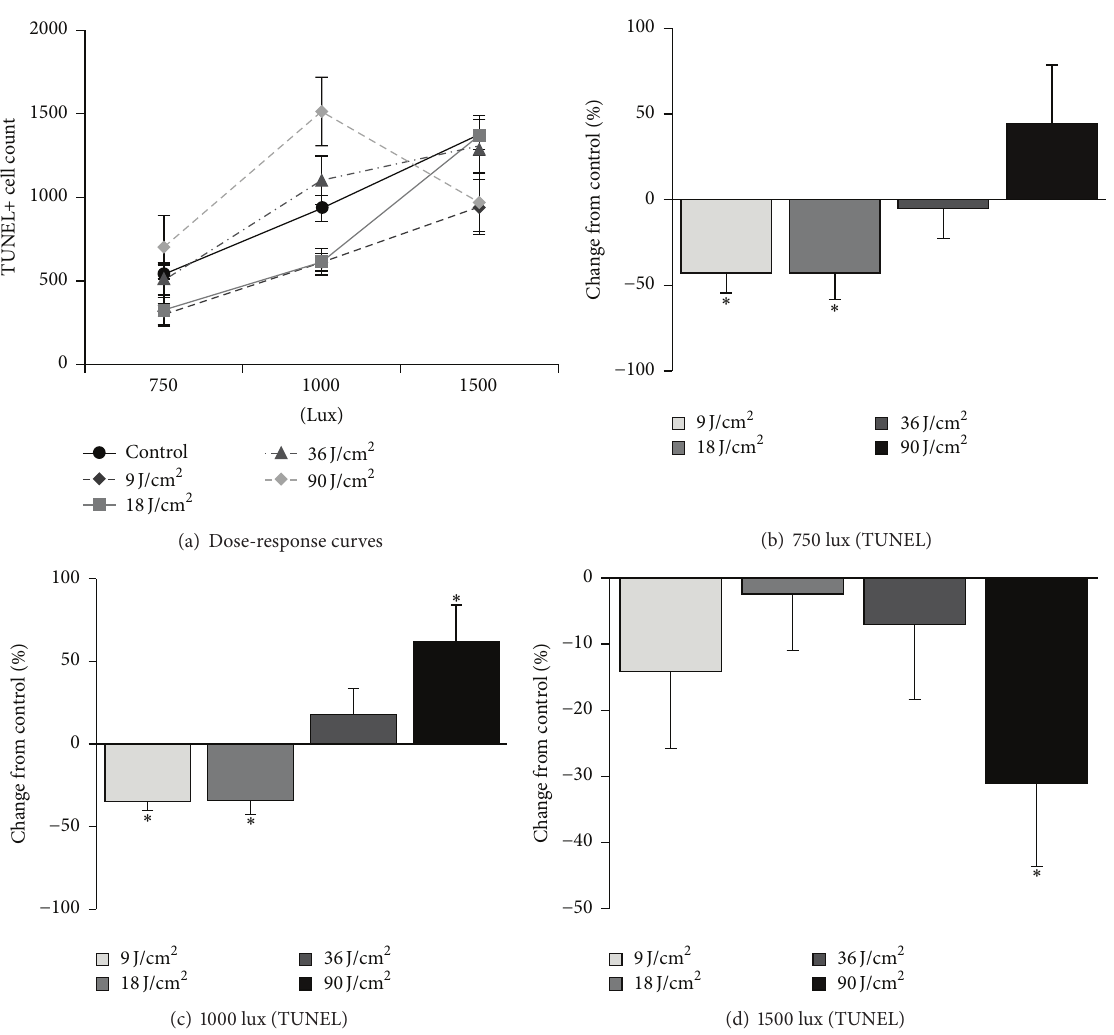
Figure 1: Effects of 670 nm light treatment on photoreceptor cell death induced by exposure to different intensities of white light. (a) Dose- response curves for 670nm light showing the impact on photoreceptor death in “low” (750 lux), “moderate” (1000 lux), and “high” (1500 lux) intensity light damage (LD) paradigms. The highest dose of red light (90 J/cm 2 ) increases levels of photoreceptor death in the low and medium intensity light damage paradigms but protects photoreceptors from cell death in high intensity bright light conditions. Panels (b)– (d) depict the percentage change of TUNEL+ cell count in the retina between the four 670 nm light treatment groups when compared to the light damage only controls. (b) 750 lux: doses of 9 and 18 J/cm 2 670 nm light significantly reduced the number of TUNEL+ cells in the ONL compared to the light damaged controls. However, there was no change in the TUNEL+ cell count in retinas treated with 36 or 90J/cm 2 670 nm light ( 𝑛 = 5 for each group). (c) 1000 lux: doses of 9 and 18J/cm 2 significantly reduced the number of TUNEL+ cells compared to controls, while a dose of 36J/cm 2 showed no difference in comparison to controls. Animals treated with 90J/cm 2 had a significant increase in TUNEL+ cells in the ONL compared to the light damaged controls ( 𝑛 = 4 for each group). (d) 1500 lux: doses of 9, 18, or 36 J/cm 2 670 nm light had no significant effect on the numbers of TUNEL+ cells, compared to controls, while treatment with 90J/cm 2 670 nm light significantly reduced the numbers of TUNEL+ cells in the ONL ( 𝑛 = 6 for control and 9 J/cm 2 ; 𝑛 = 5 animals for 18 J/cm 2 ; 𝑛 = 4 for 36 J/cm 2 and 90J/cm 2 groups) (“ ∗ ”denotes significance 𝑃 < 0.05 ; error bars represent